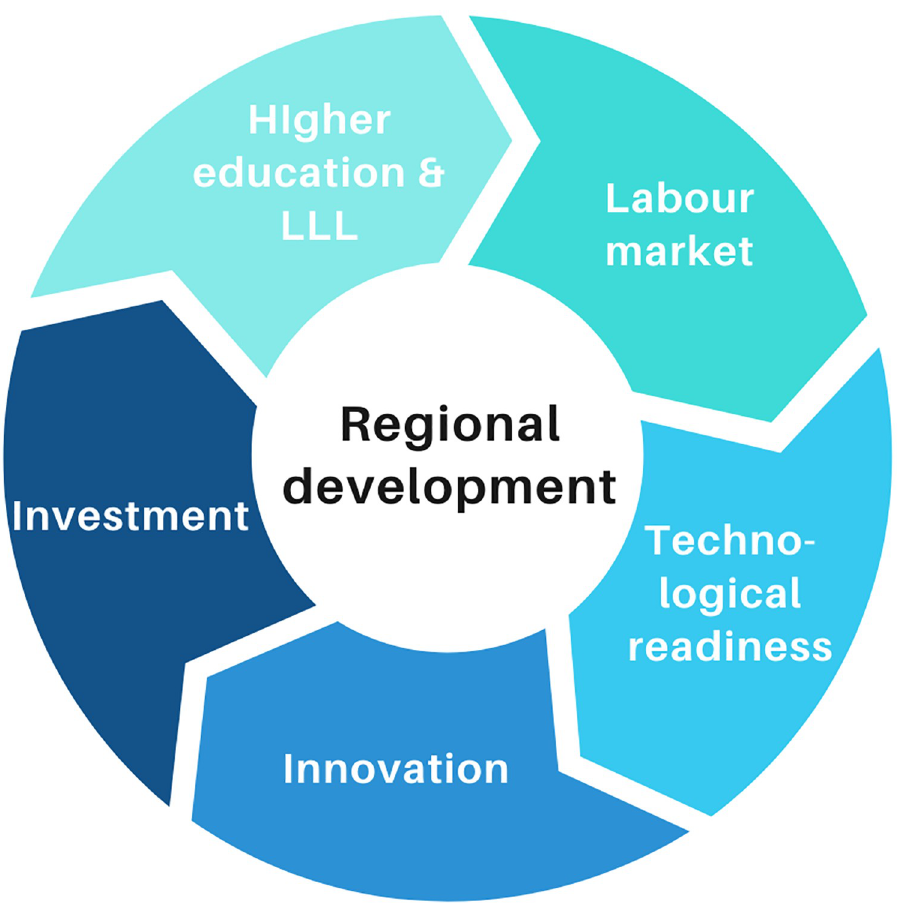
Fig 1. I4.0-related dimensions of regional